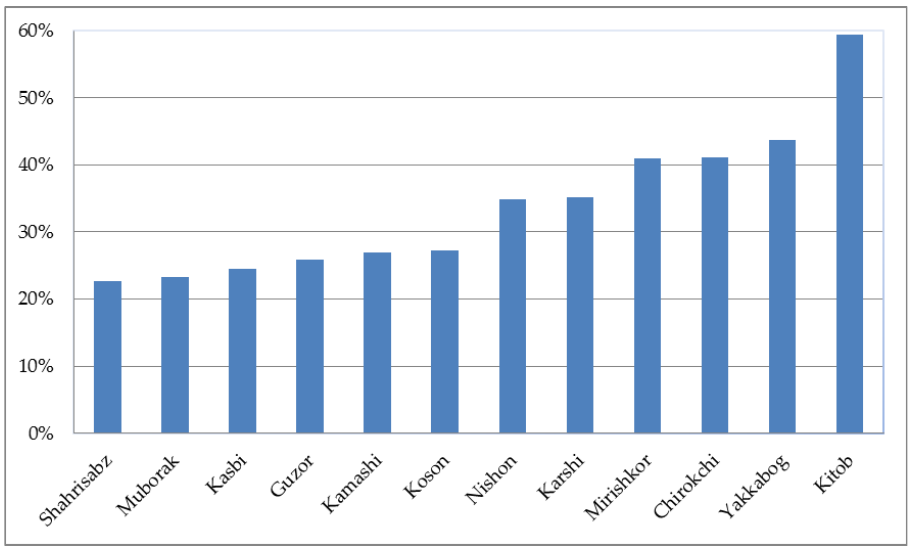
Figure 4. ISF collection rates in all districts of Kashkadarya Province as of June 2016.